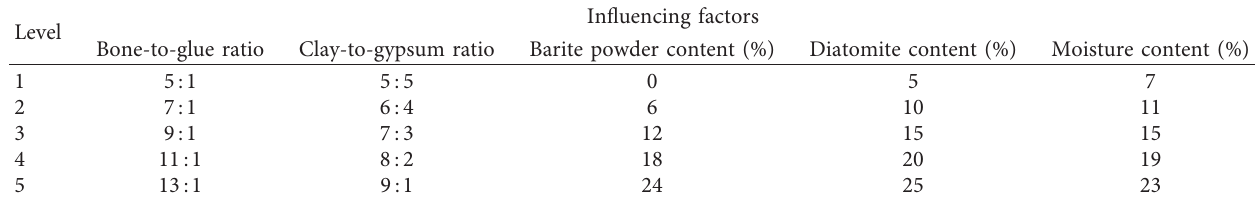
Table 1: Orthogonal design level of similar materials.